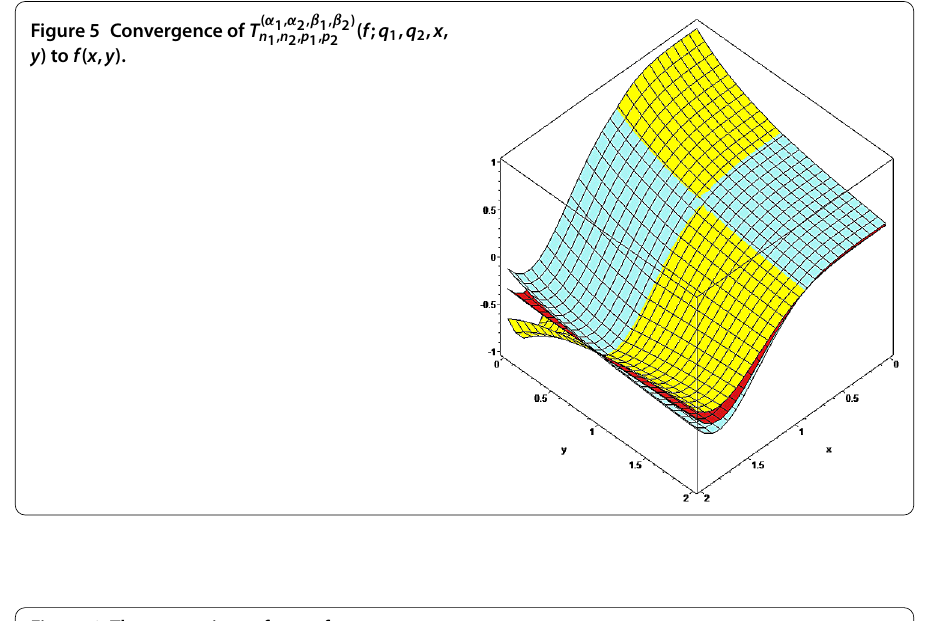
Figure 6 The comparison of rate of convergence of K ( α 1, α 2, β 1, β 2) n 1, n 2, p 1, p ( f ; q 1 , q 2 , x , y ) and T ( α 1, α 2, β 1, β 2) n 1, n 2, p 1, p 2 q 1 , q 2 , x , y ) to f ( x , y ).